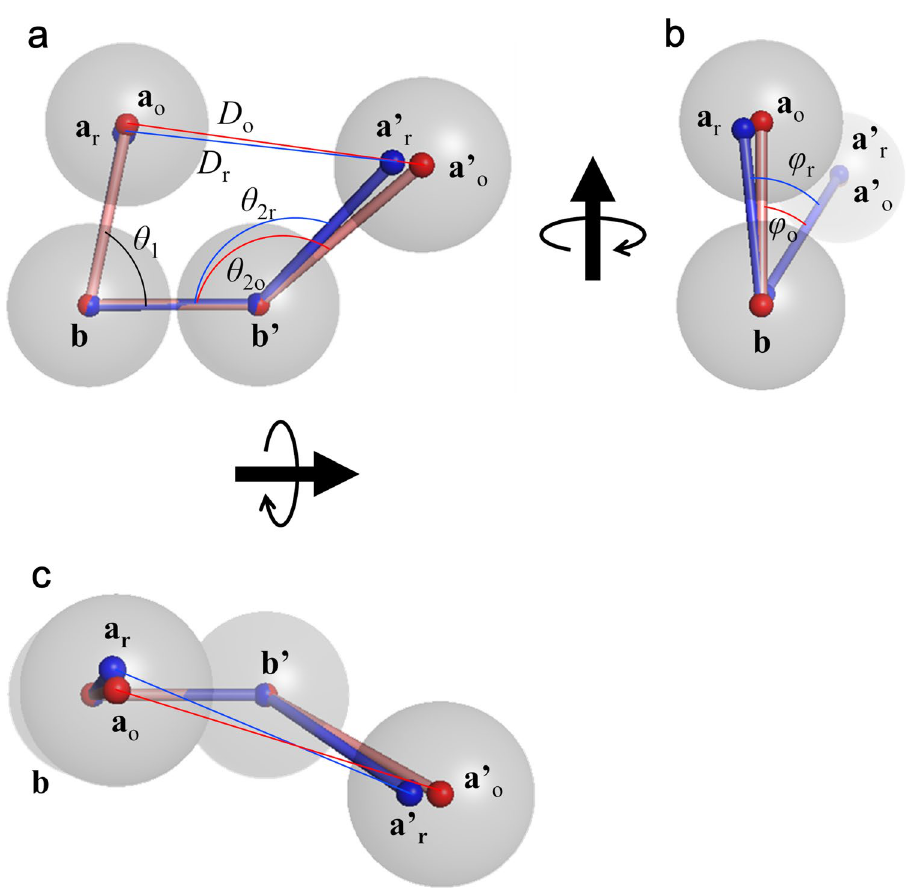
Figure 4. Ball-and-stick models of ER-60. The averaged position of each domain is shown with red ball-and- stick models and with blue ball-and-stick models for ox- and red-models, respectively. The ox- and red-models are aligned by the b and b ′ domains. Gray balls roughly indicate domains as an eye guide. θ 1 is the θ a–b–b ′ . θ 2o and θ 2r indicate the θ b–b ′ –a ′ of the ox- and red-models, respectively. φ o , and φ r indicate the φ a–b–b ′ –a ′ of the ox- and red-models, respectively.